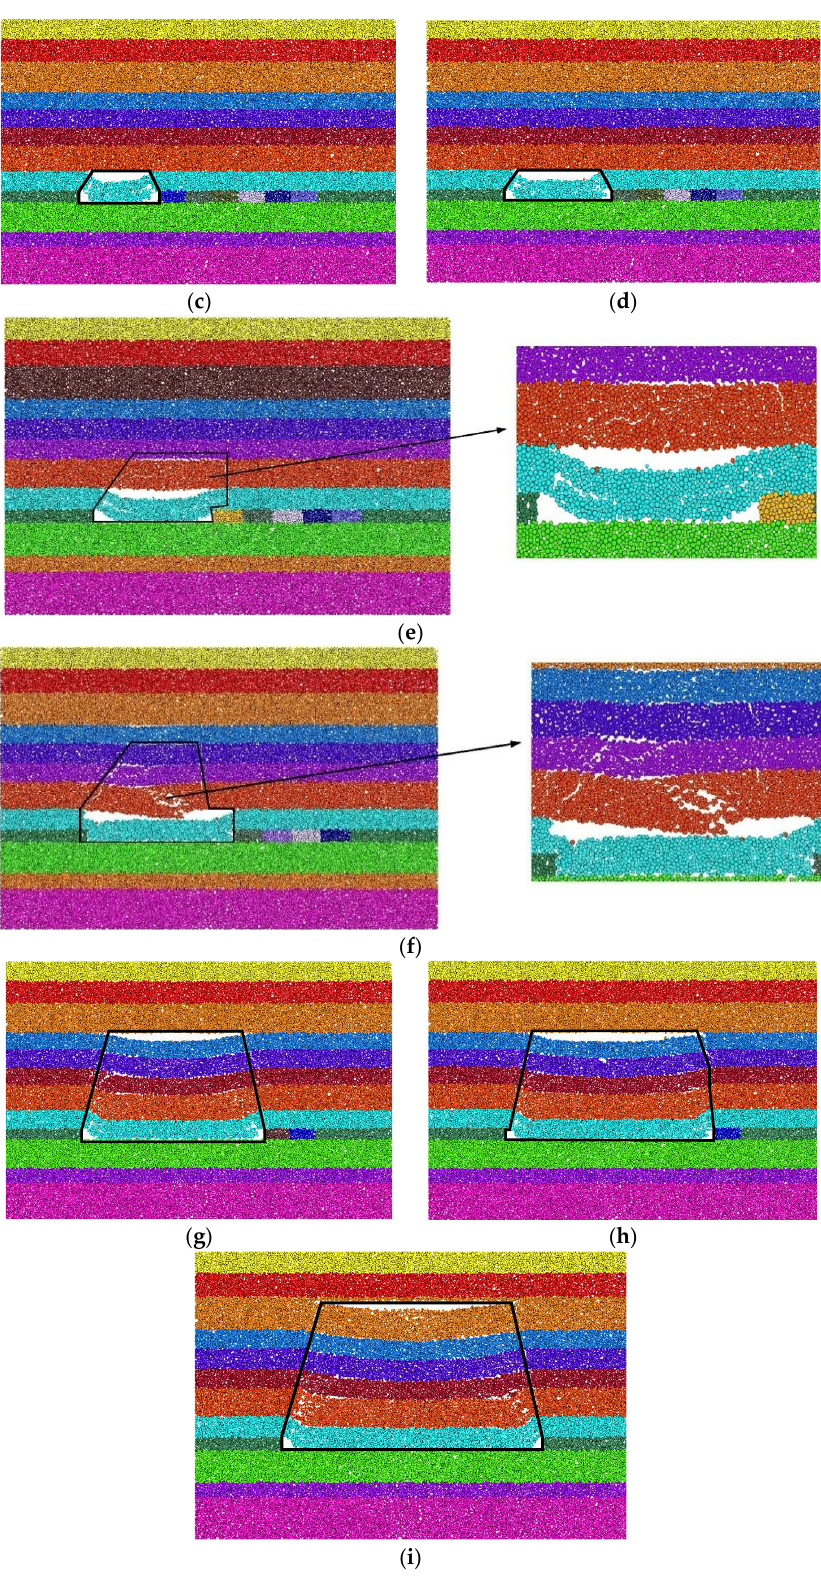
Figure 18. Failure modes of overburden rock with different advancing distances. ( a ) Working face advance 10 m; ( b )Working face advance 20 m; ( c ) Working face advance 30 m; ( d ) Working face advance 40 m; ( e ) Working face advance 50 m; ( f ) Working face advance 60 m; ( g ) Working face advance 70 m; ( h ) Working face advance 80 m; ( i ) Working face advance 90